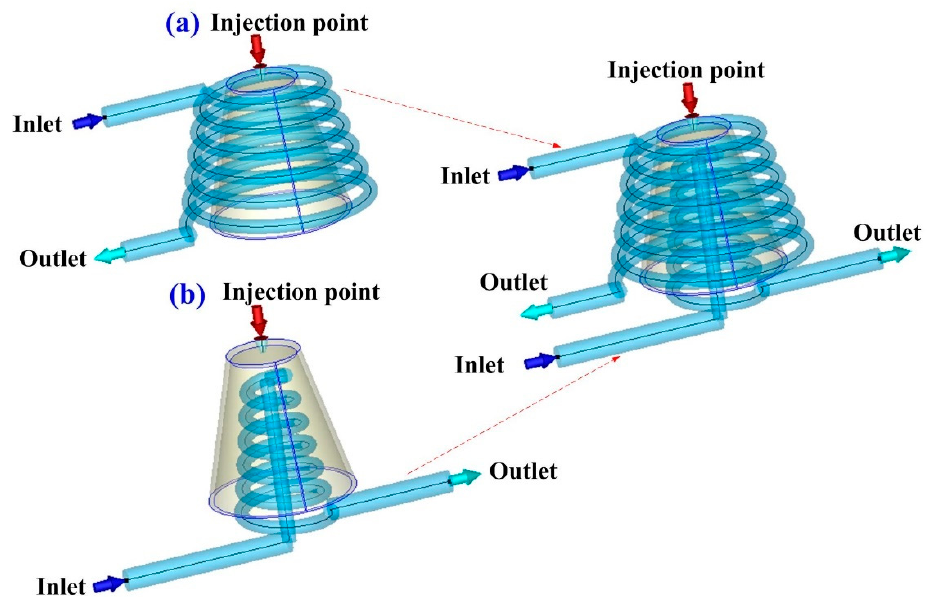
Figure 3. Schematic illustration of the injection molded part with conformal cooling channels of ( a ) cavity insert and ( b ) core insert.